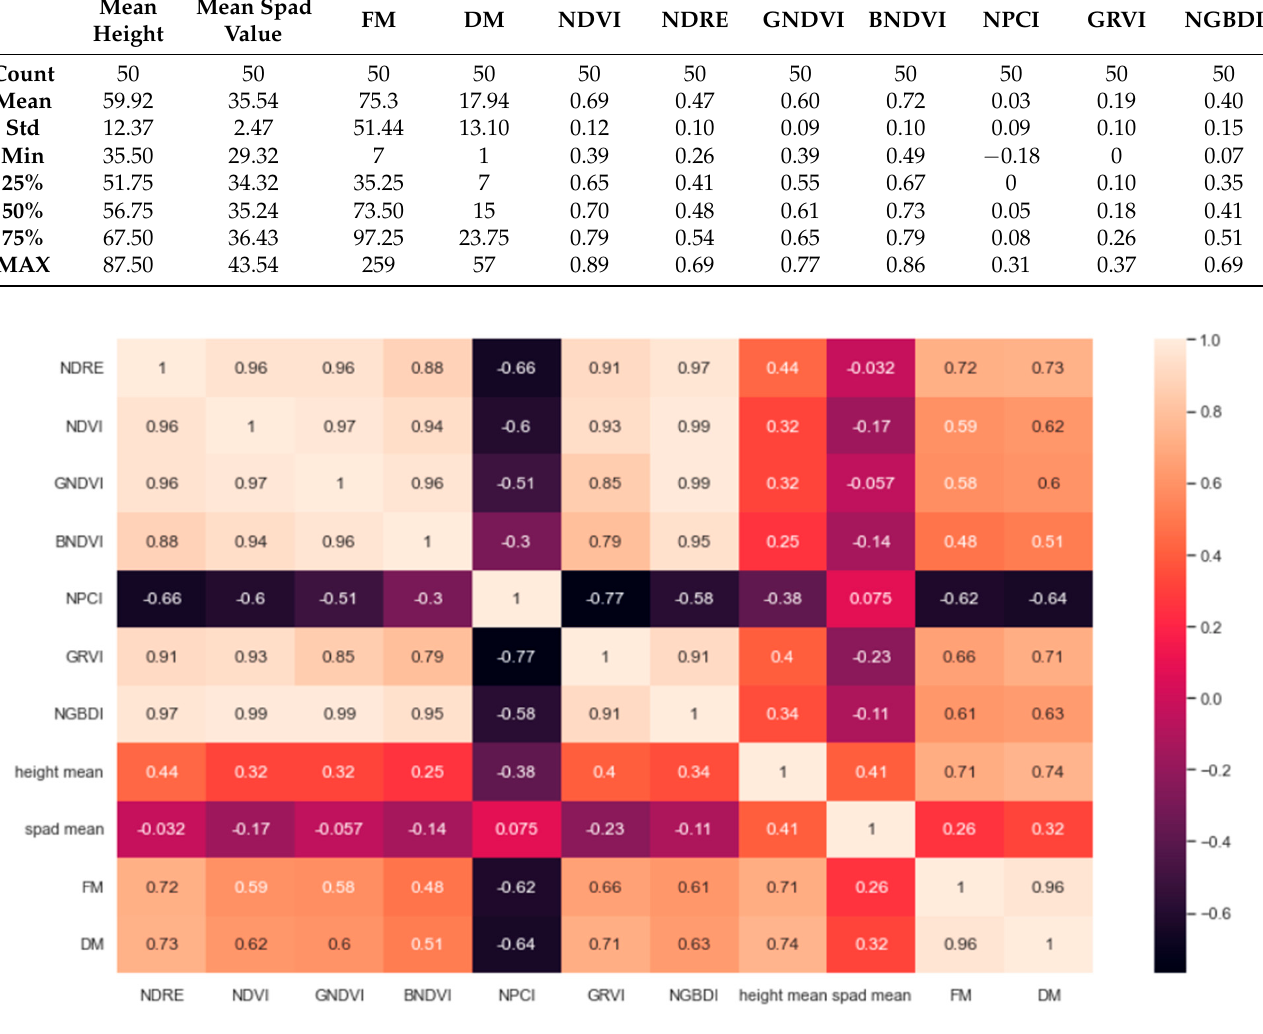
Figure 5. Correlation graph between GTD and satellite remote sensing variables. The lighter color intensity shows a higher correlation near one, and the darker color intensity shows near − 0.8 (nega- tive